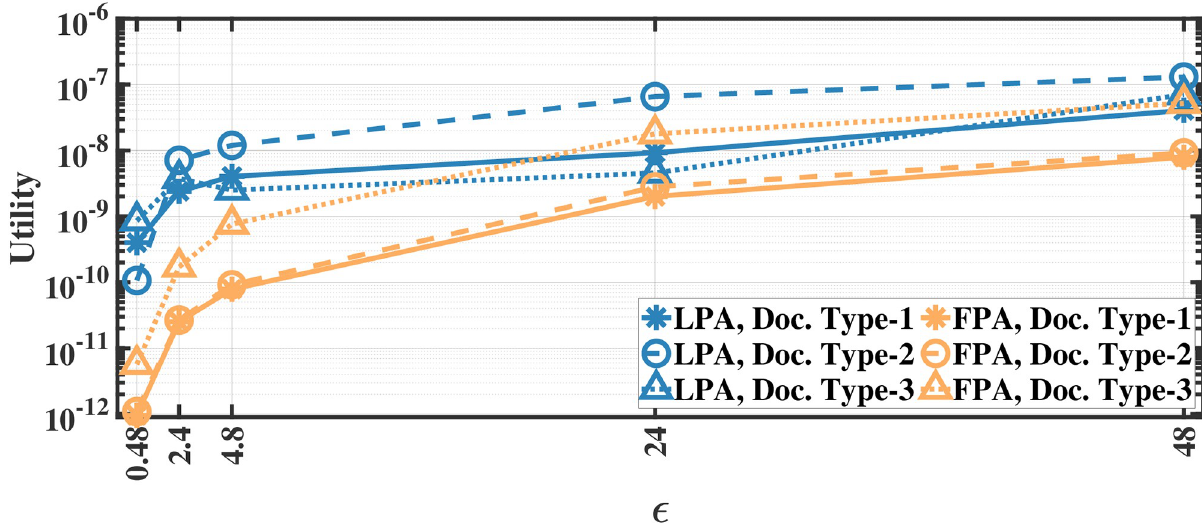
Fig 7. Utility of the LPA and FPA for MPIIDPEye.